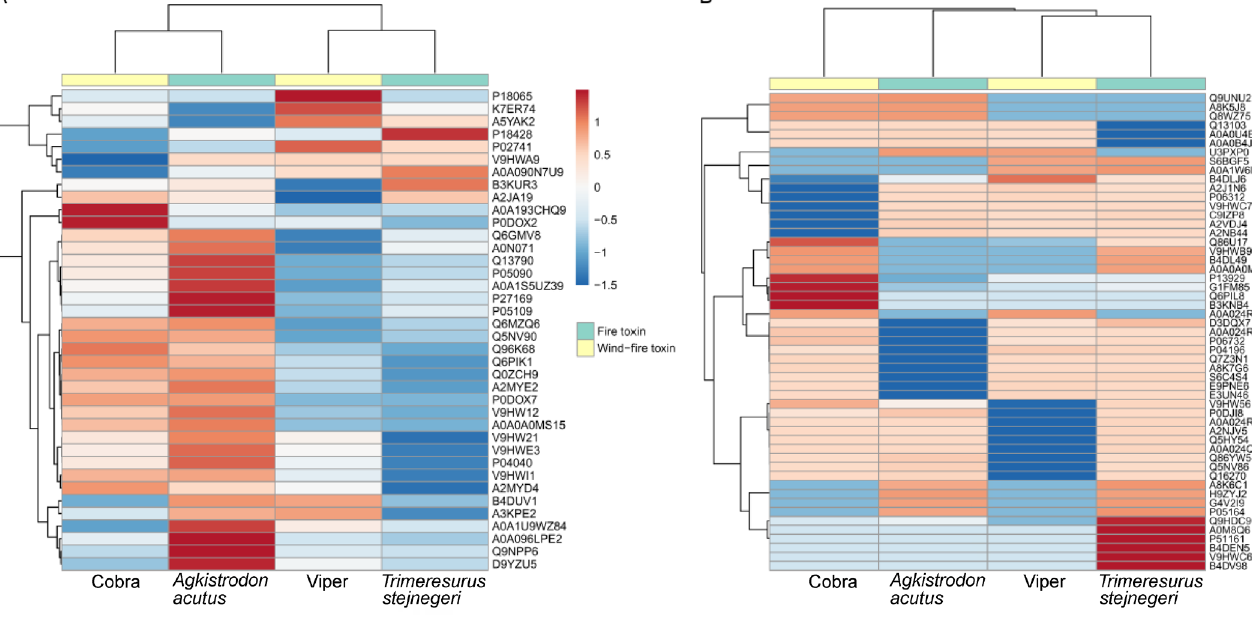
Figure 3. A biological heat map of DAP clustering based on fold changes between each snakebite subgroup and the healthy control group. (A) Thirty-eight proteins with statistically significant differences in expression were shown. (B) Fifty-five proteins displayed no expression in one group by subgroup comparisons. The color depth from blue to red represents the level of change of protein abundance; whereas blue and red represent, respectively, proteins with decreased and increased expression relative to the healthy control